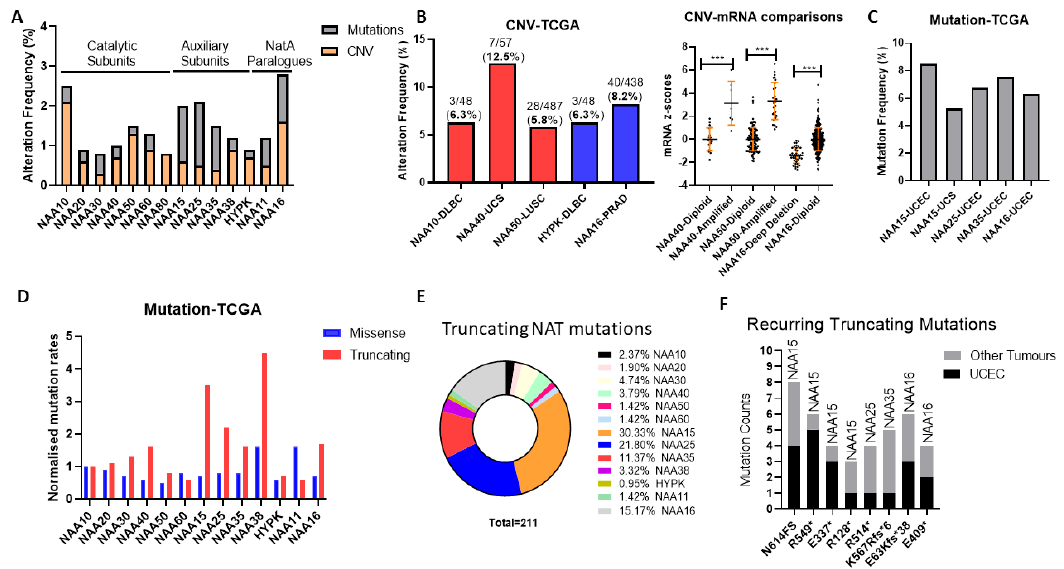
Figure 1. Genomic alteration of N-terminal acetyltransferase (NAT) genes across The Cancer Genome Atlas (TCGA) pan-cancer study of 32 cancer types. ( A ) Oncoprint displaying average frequency of copy number variants (CNV) and mutations for each NATs across cancer types; ( B ) Tumour types with greater than 5% frequency of NAT amplifications or deletions (left panel) and association between amplification and mRNA levels in tumours (right panel). DLBC—Lymphoid Neoplasm Diffuse Large B-cell Lymphoma, UCS—Uterine Carcinosarcoma, LUSC—Lung squamous cell carcinoma; ( C ) Tumour types with greater than 5% frequency of NAT mutations. UCEC—Uterine Corpus Endometrial Carcinoma; ( D ) counts of missense and truncating mutations for NAT genes across TCGA Pan-Cancer study normalised to protein length. Mutation counts for each NAT gene were normalised first to the length of the associated ORF and then to the corresponding value of NAA10. For NAA80, mutation data were not available; ( E ) Pie-chart depicting the frequency of truncating mutations for every NAT gene across the TCGA pan-cancer study; ( F ) Mutational count of recurring (at least three occurrences) truncating mutations of NAT genes in UCEC and other tumour types. *** p < 0.001 Student’s t-test